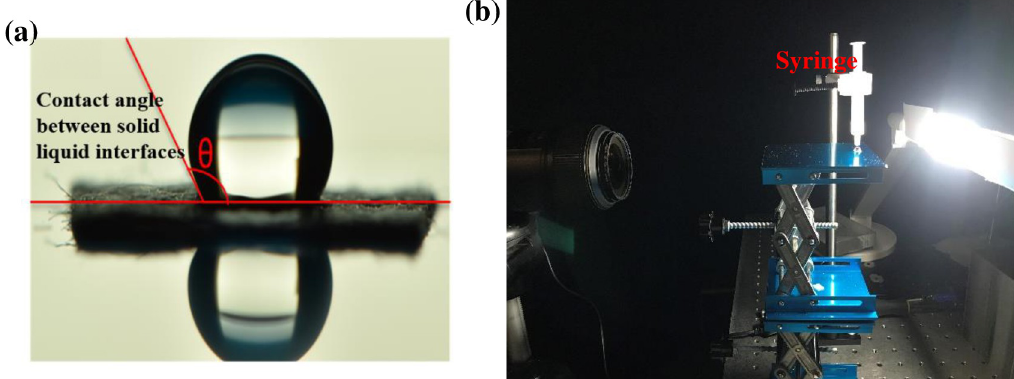
Fig 9. (a) Contact angle measurement between solid liquid interfaces and (b) surface wettability testing